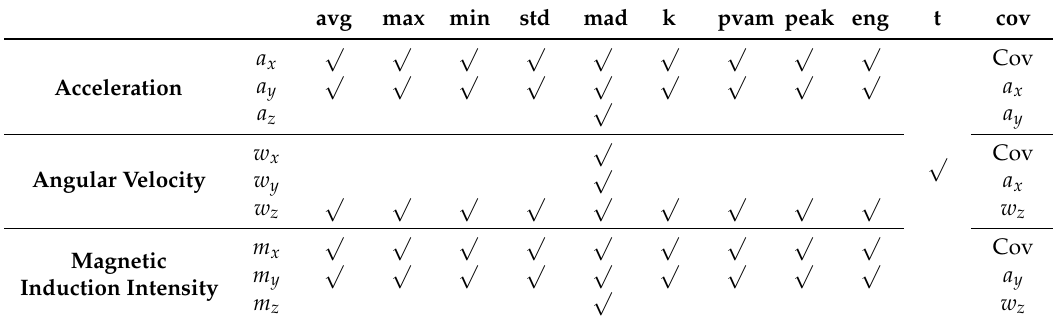
Table 5. List of features